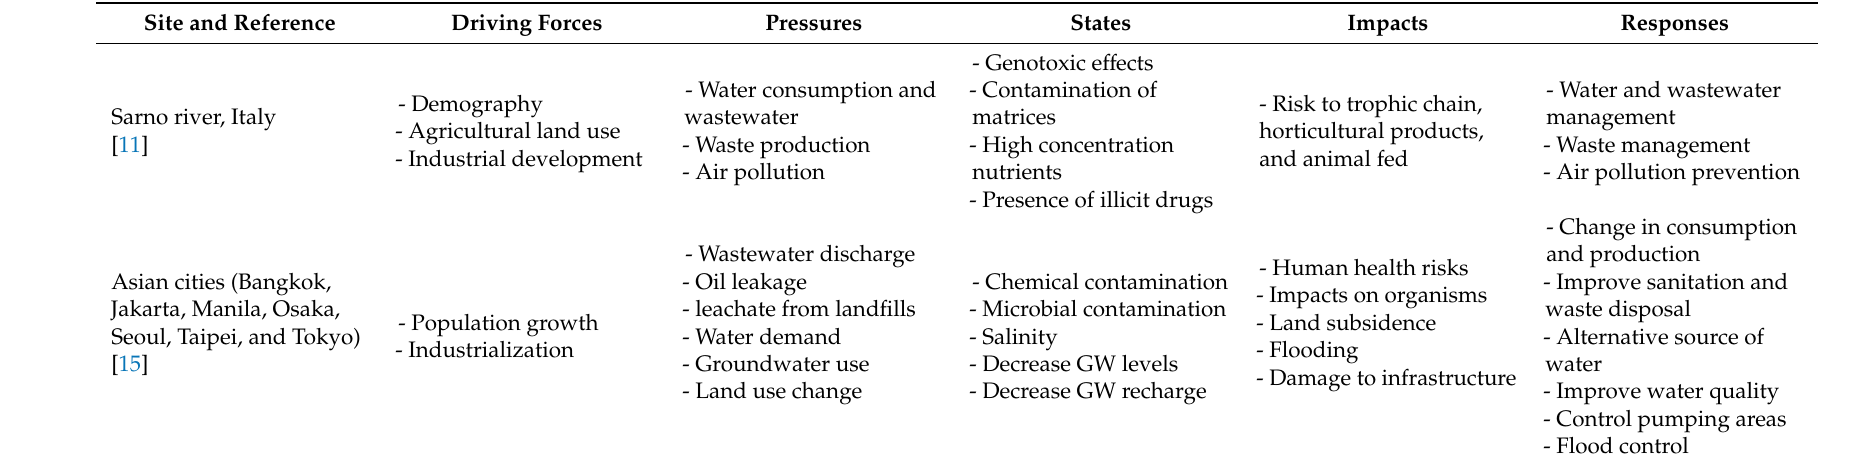
Table 9. Comparative DPSIR frameworks in